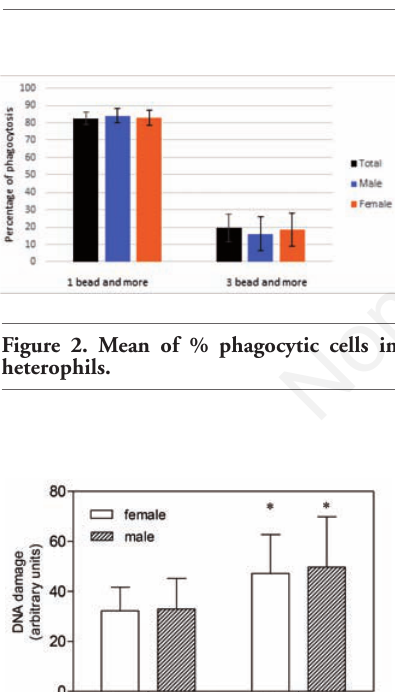
heterophils.Figure 1. Example of gannet blood cells populations using a BD Accuri™ C6 using a density plot of complexity versus size of the cells.